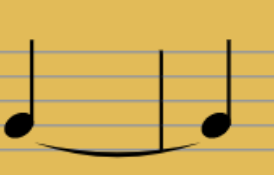
Figure 3. An example of the simplest binding pattern (two quarter notes) for the initial 11